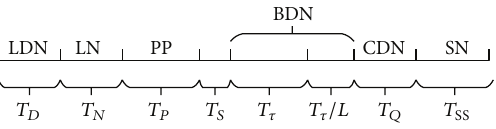
Figure 3: Time periods of CETC algorithm